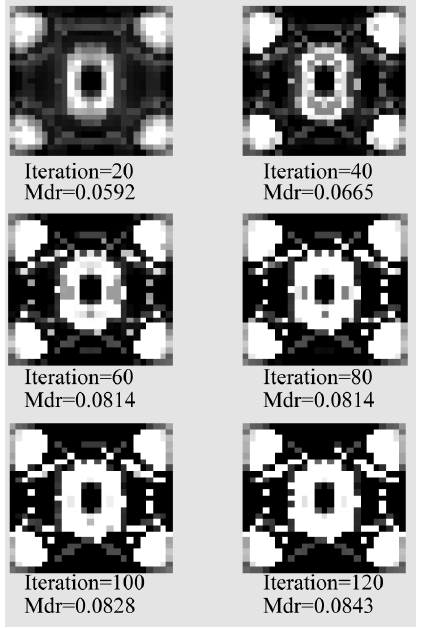
Fig. 22. Optimal distribution of damping material at different iteration numbers, vf = 0.6.